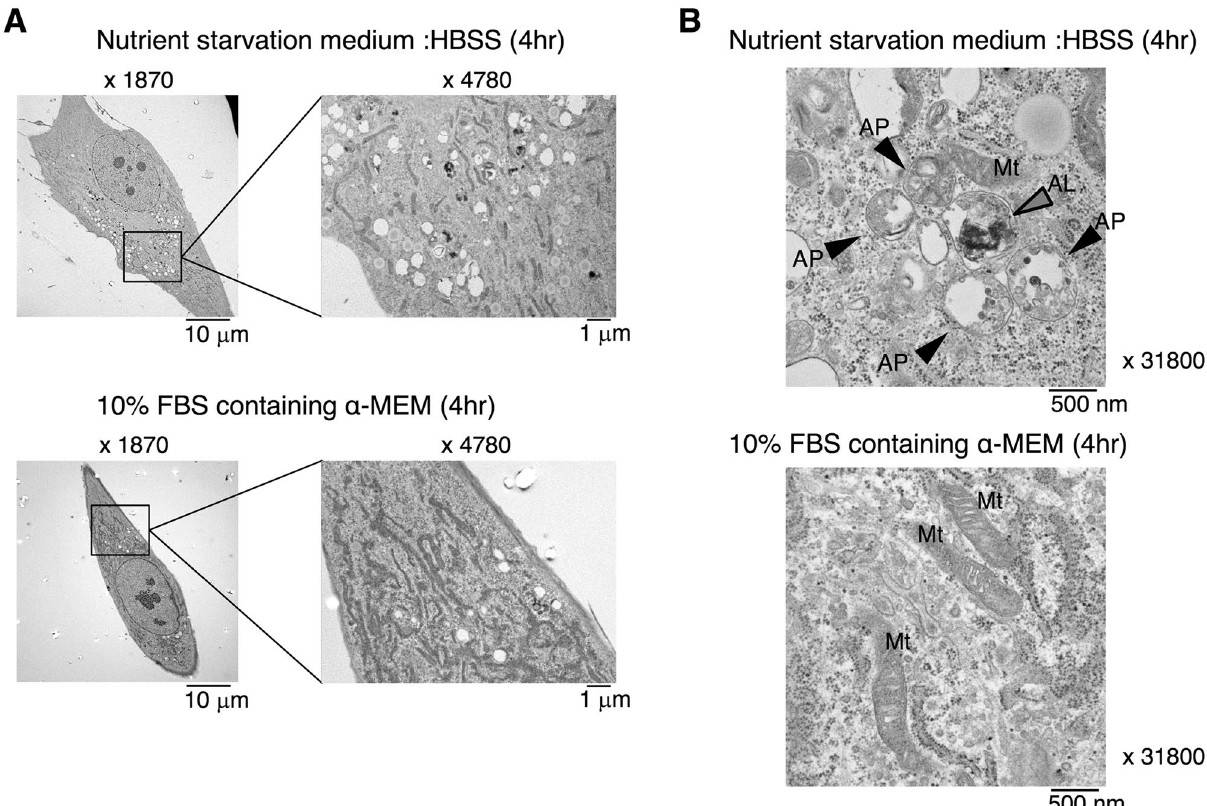
Figure 1. Autophagy is induced in human periodontal ligament (HPDL) cells in vitro. ( A ) Transmission electron microscopy showed the induction of double membrane coated vacuoles after treatment with no-serum Hank’s balanced saline solution (HBSS) for 4 h (1870 ×) (right). Enlarged image of the bold square in the left panel (4780 ×). ( B ) Typical image of autophagosome after treatment with no-serum HBSS for 4 h is shown in upper panel (31,800 ×). AP; Autophagosome AL; Autolysosome Mt;